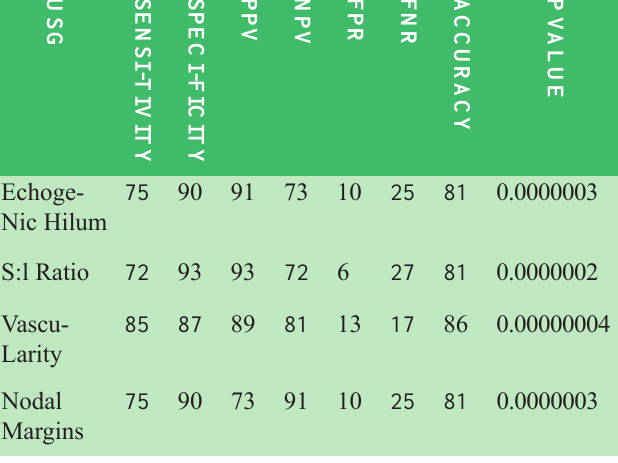
Table 1: Summary of validity of USG in